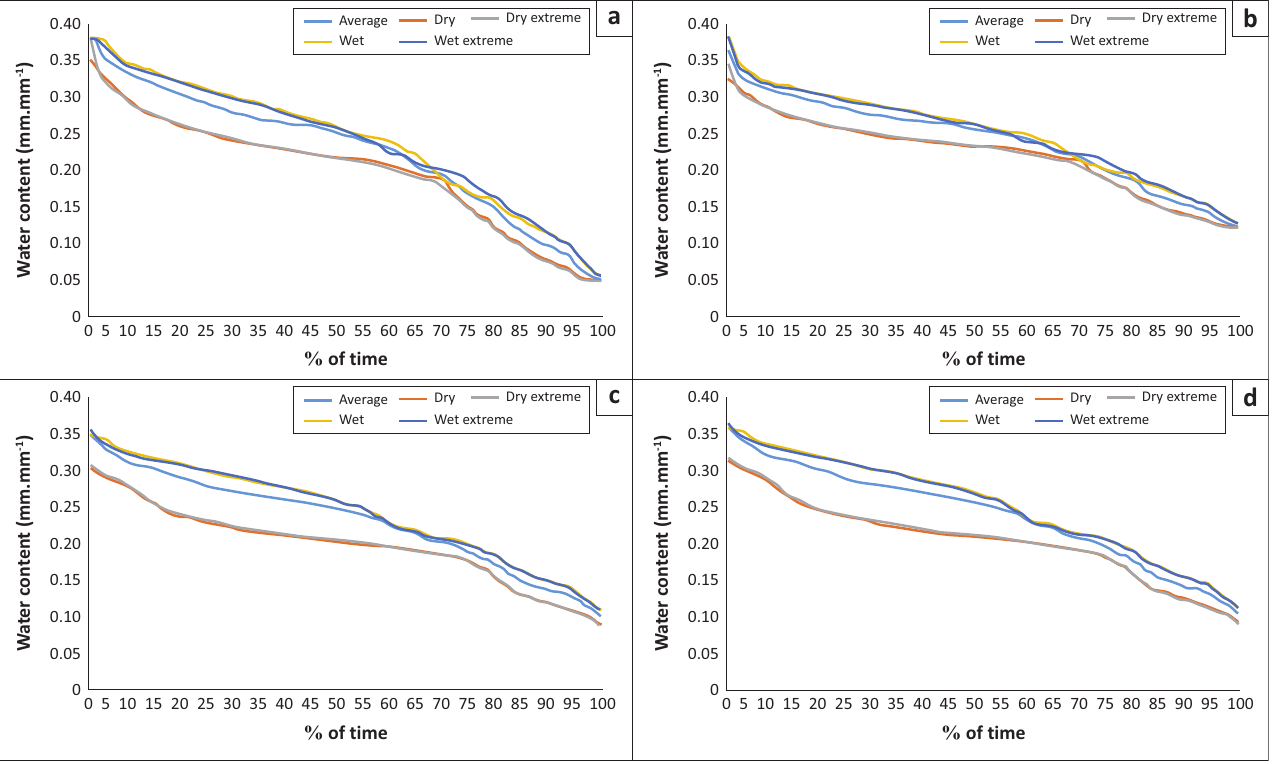
FIGURE 4: Duration of exceedance curves of soil water contents of (a) orthic A horizon and (b) yellow-brown apedal B horizon of the Clovelly soil on the crest position; and (c) orthic A horizon and (d) stratified alluvium B horizon of the Dundee soil in the valley